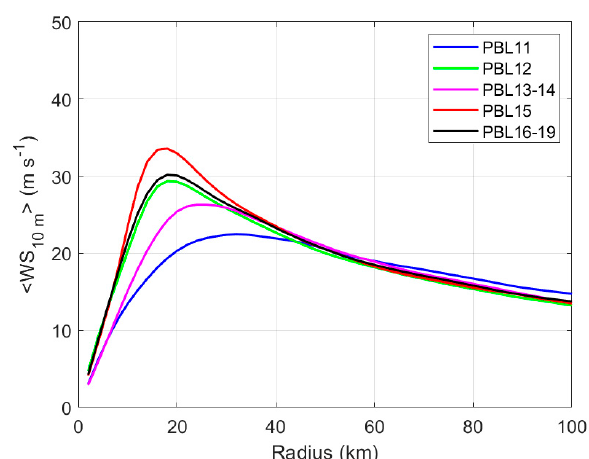
Figure 4. Radial profiles of the azimuthally averaged wind speed at 10 m altitude (<WS 10m >) during the rapid intensification period (t = 12–30 h) in the five idealized HWRF simulations.